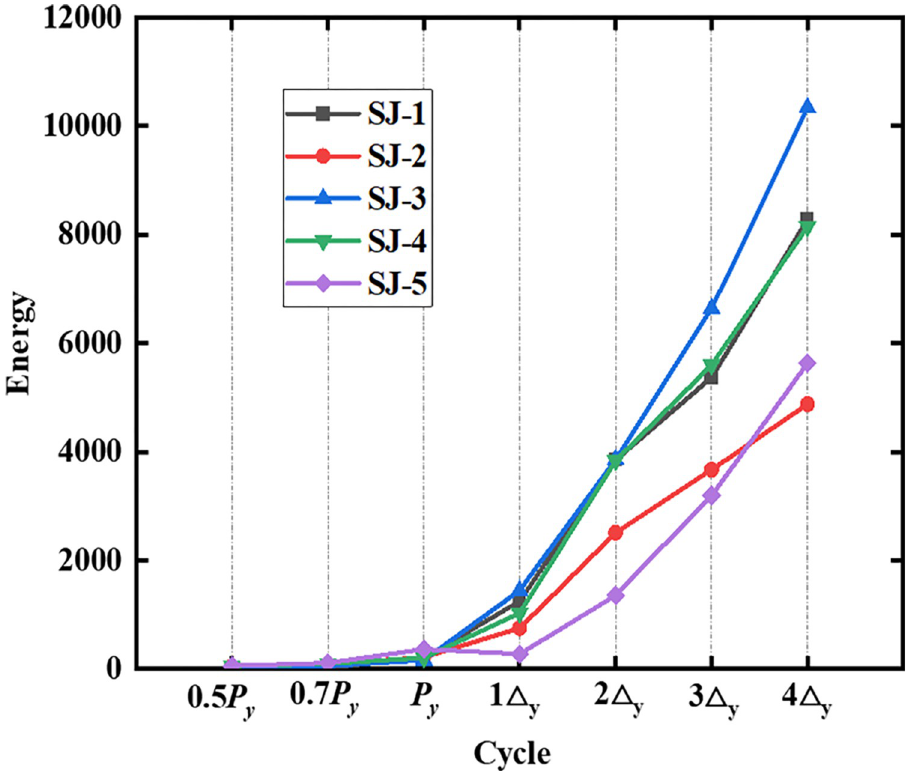
Fig 24. Cumulative energy dissipation of the five